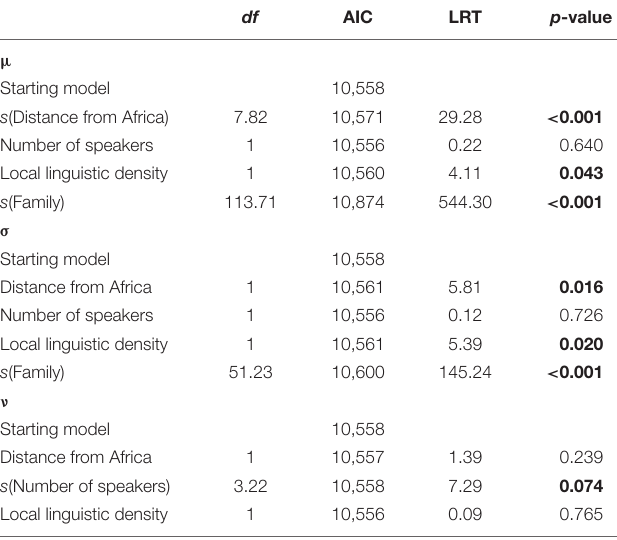
TABLE 7 | Likelihood ratio tests (LRT) for the predictors of the (BCT, µ , σ , and ν ) GAMLSS model described in Table 6